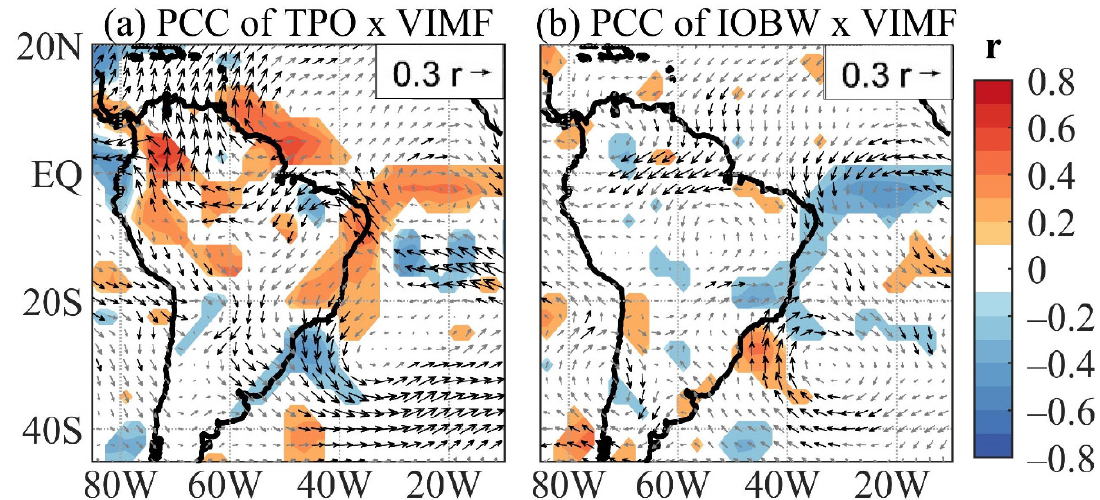
Figure 6. Correlations for the precipitation (PRP) during southern summer: ( a ) TCC of the TPO and PRP; ( b ) PCC of the TPO and PRP; ( c ) PCC of the IOBW and PRP. Continuous line encompasses significant correlations at a 95% confidence level using Student’s t ‐ test.